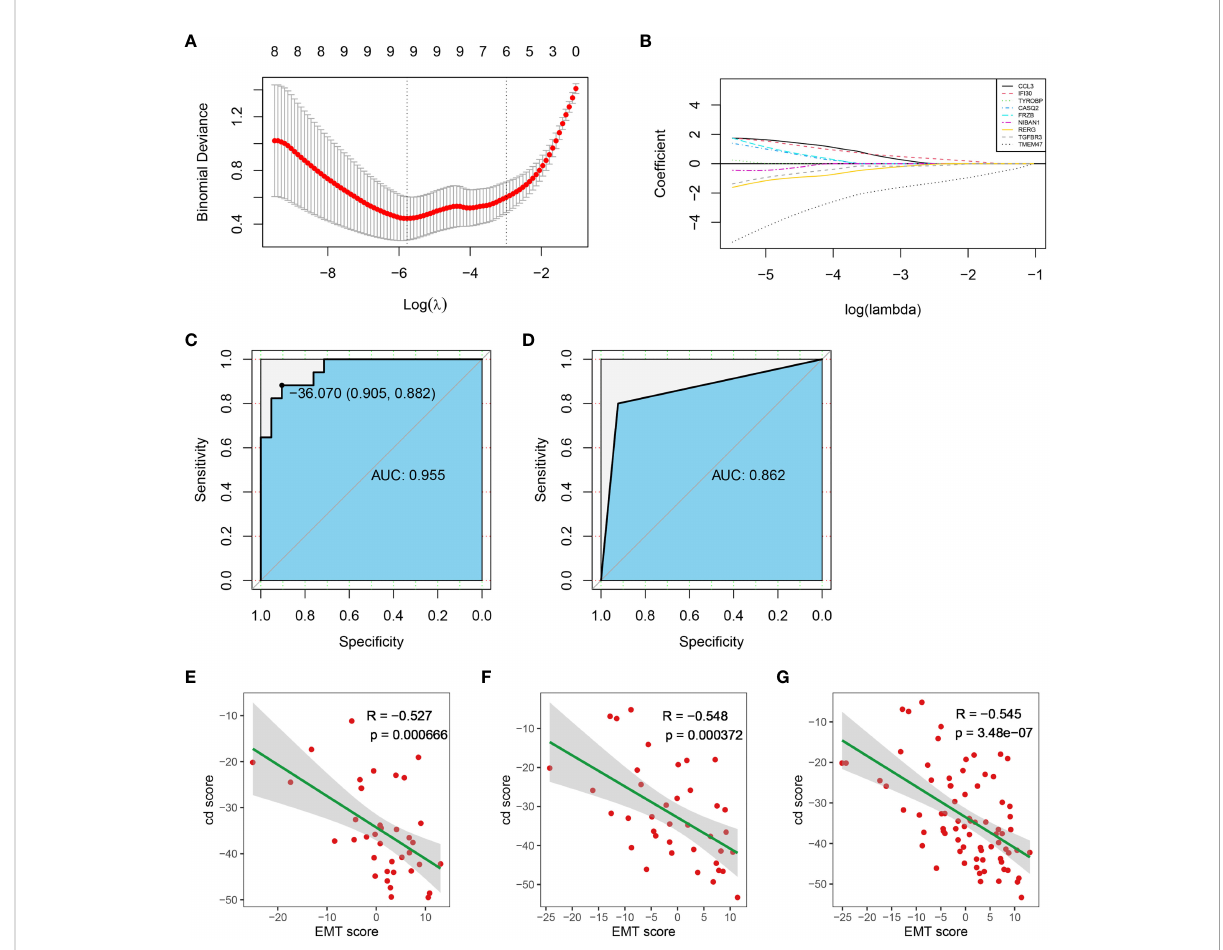
FIGURE 6 Construction of the diagnostic model. (A) Diagnostic markers screening. (B) The coef fi cients of all diagnostic markers. (C) ROC of the diagnostic model with the 14 diagnostic markers in the training dataset. (D) Validation of the diagnostic model in the test dataset. (E – G) . The correlation between cd score and EMT score in test dataset, training dataset and entire dataset, respectively. (AUC, Area Under